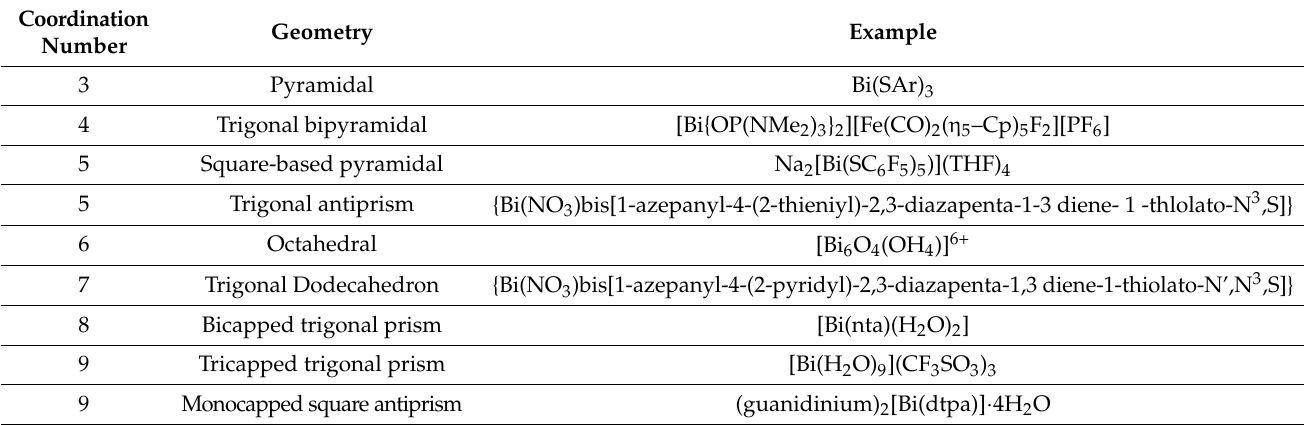
Table 1. Summary of geometries for each coordination number. Table was adapted from Sun H. et al., 1997, with permission from [41], John Wiley and Sons,